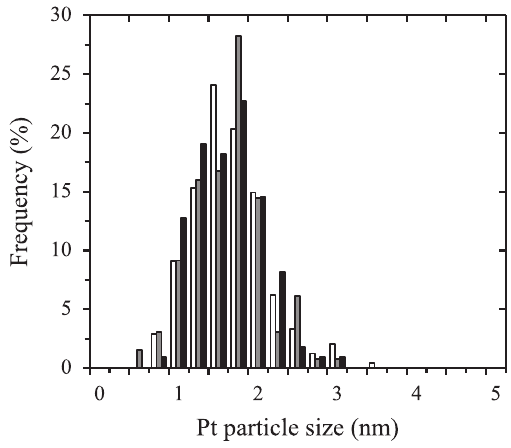
Fig. 6 Estimated Pt content (red line and ◆ ) and nanocluster size (blue line and ▲ ; on secondary vertical axis) for varied Pt precursor exposure times and 1 ALD cycle.